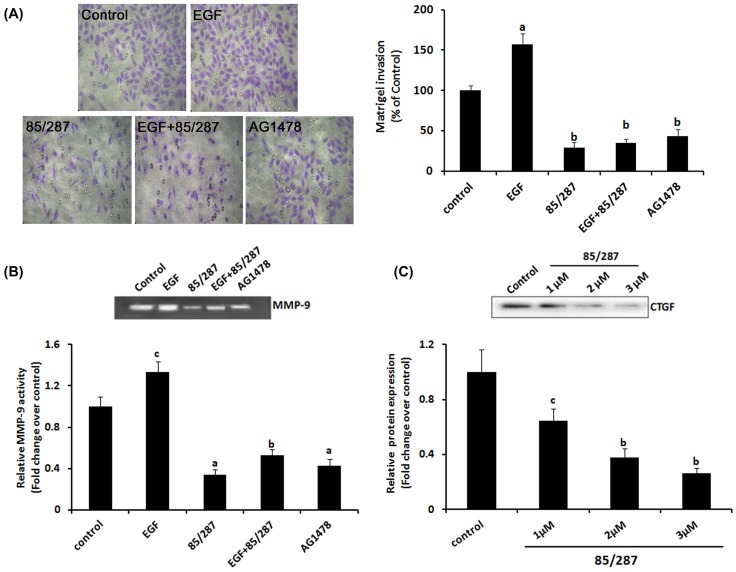
Effect of compound CDRI-85/287 on the invasive properties of MDA-MB 231 cells.(A) Transwell migration assay. MDA-MB231 cells were seeded in the upper chamber with vehicle, EGF, CDRI-85/287, EGF along with the compound CDRI-85/287 or AG1478 added in the lower chamber. Cells that migrated to the low chamber were fixed, stained, and counted by light microscopy as described in Methods (left). These results are representative images of three independent experiments. The graph in the right panel shows the average number of migrated cells in three wells from three independent experiments (random fields were scanned and number of cells from four fields per well were counted). Results are expressed as mean ± SEM, n = 3. p values are a-p<0.001, b<0.01, c-p<0.05 and d-p>0.05 vs. control. (B) Inhibition of MMP-9 activity by CDRI-85/287 in breast cancer cells. MDA-MB 231 cells were treated as indicated for 12 h, conditioned media was collected and MMP activity was analyzed by gelatin zymography. Upper panel shows the representative gel image and lower panel shows the densitomentric analysis of band intensity. Results are expressed as mean ± SEM, n = 3. p values are a-p<0.001, b<0.01, c-p<0.05 and d-p>0.05 vs. control. (C) Western blot analysis to demonstrate the effect of CDRI-85/287 on the expression of CTGF in conditioned media. Cells were treated with increasing concentrations of CDRI-85/287 for 24 h, conditioned media was collected and subjected to western blotting for the expression of CTGF. Results are expressed as mean ± SEM, n = 3. p values are a-p<0.001, b<0.01, c-p<0.05 and d-p>0.05 vs. control